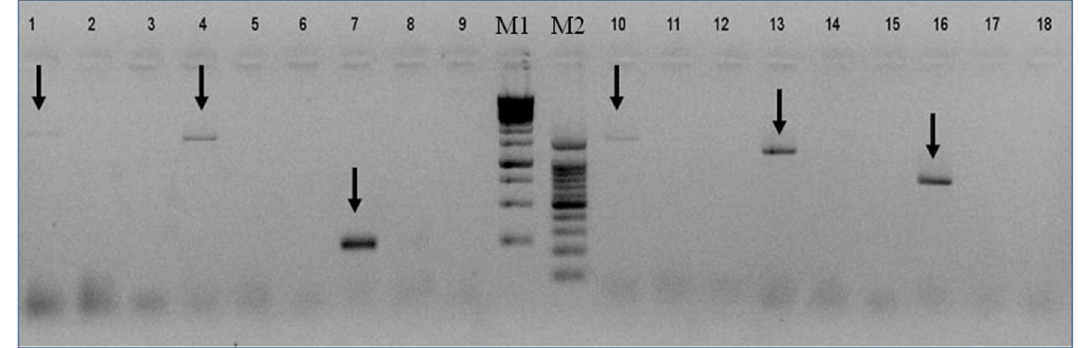
Figure 3. Presence of VOV-1 in virome of V. destructor mites and its absence in honeybees. V. destructor mite virome: lanes 1, 4, 7, 10, 13, and 16; Honeybee virome: lanes 2, 5, 8, 11, 14, and 17; NTC (nontemplate control): lanes 3, 6, 9, 12, 15, and 18; M1 and M2: GeneRuler Marker TM 1 kb, 100 bp DNA ladders, respectively. Arrows: VOV-1 segments (1–6).